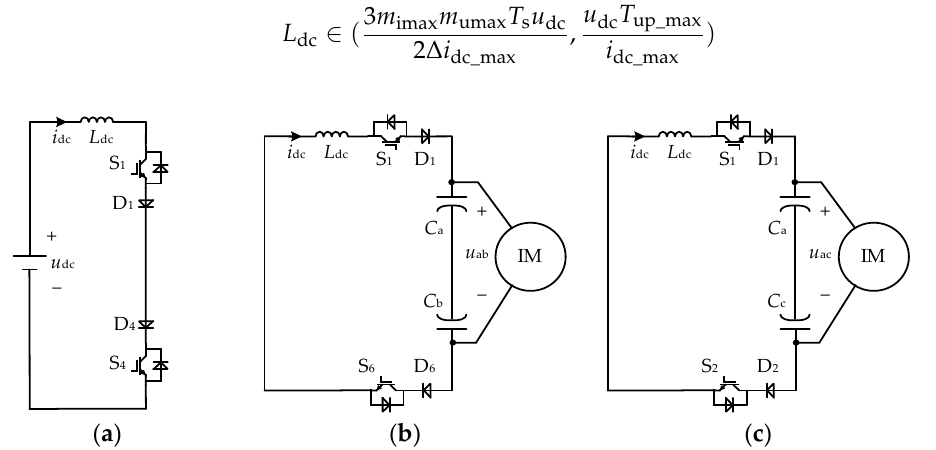
Figure 3. The equivalent circuits of charging and discharging for L dc . ( a ) Equivalent charging circuit; ( b ) equivalent discharging circuit when S 1 and S 6 are turned on; ( c ) equivalent discharging circuit when S 1 and S 2 are turned on.